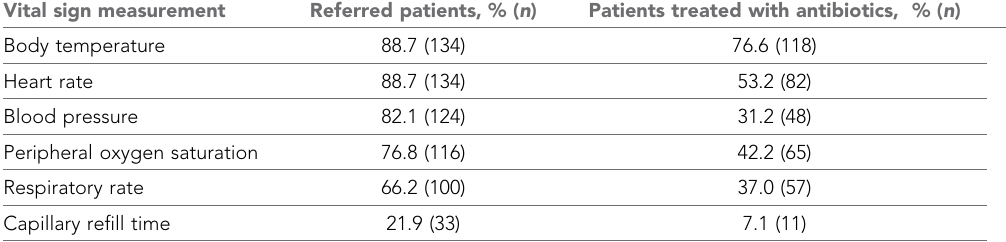
Table 3. Frequency of performed vital signs measurements in the self-reported cases of referred patients